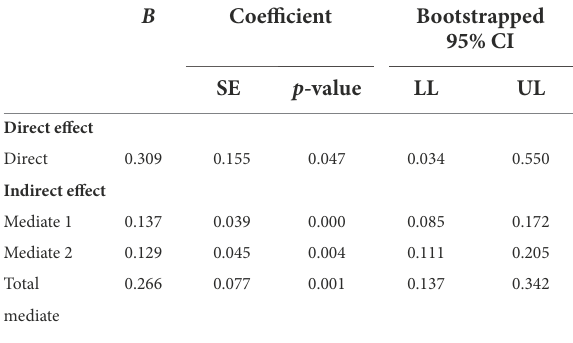
TABLE 3 Bootstrapping effect analysis.